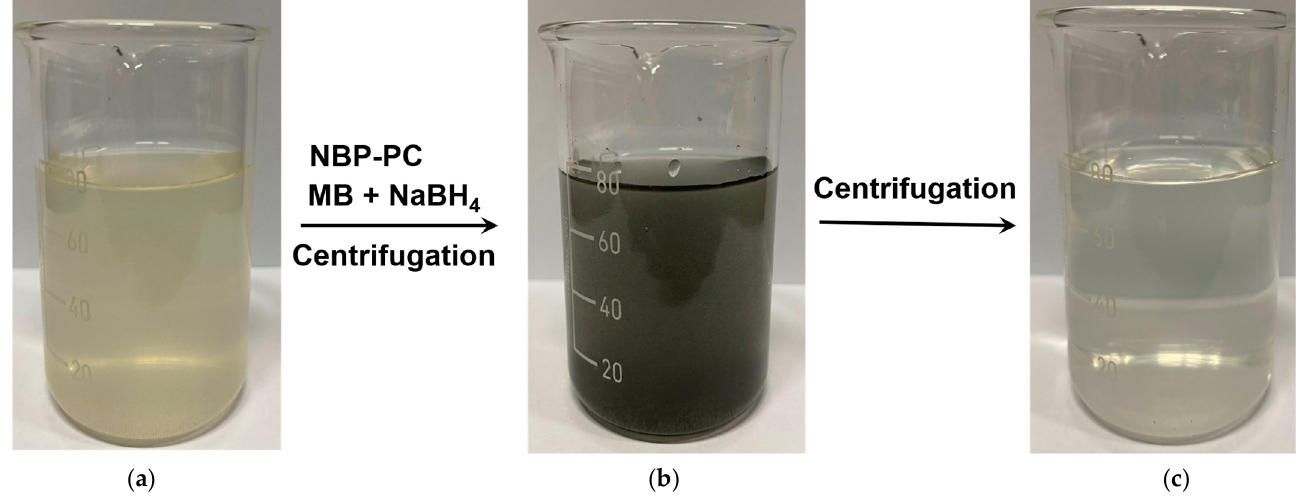
Figure 9. Photographs of dye-polluted ( a ) wastewater, ( b ) reduction after 15 min, and ( c ) clean water (after centrifugation).